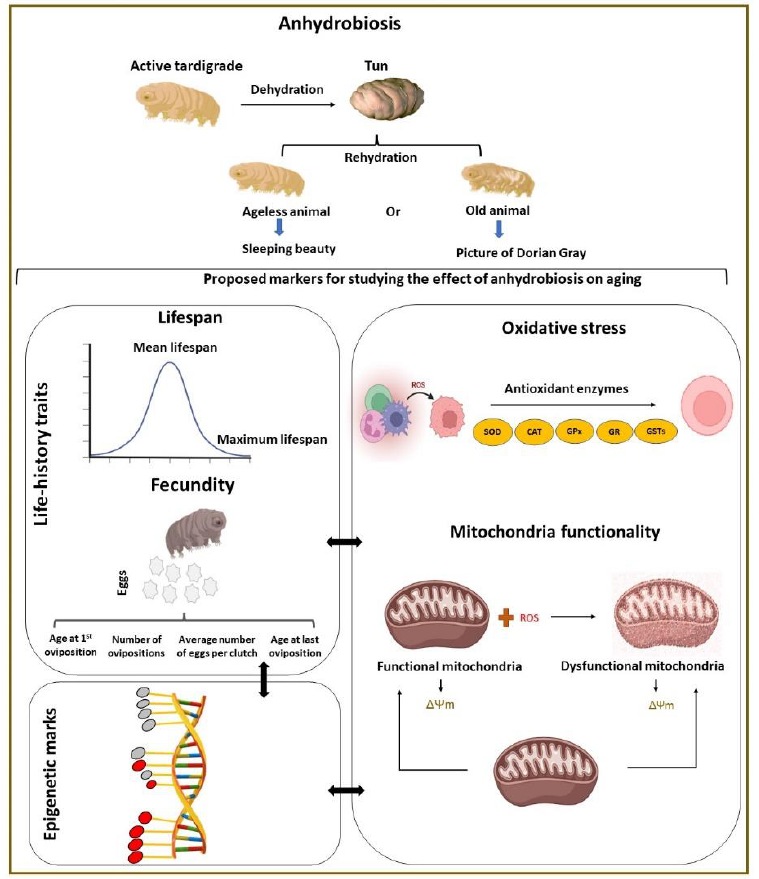
Figure 1. Life-history and cellular traits for studying the effect of anhydrobiosis on aging. ROS: reactive oxygen species; SOD: superoxide dismutase; CAT: catalase; GPx: glutathione peroxidase; GR: glutathione reductase; GSTs: glutathione S-transferase; ∆Ψ m: mitochondrial membrane potential.